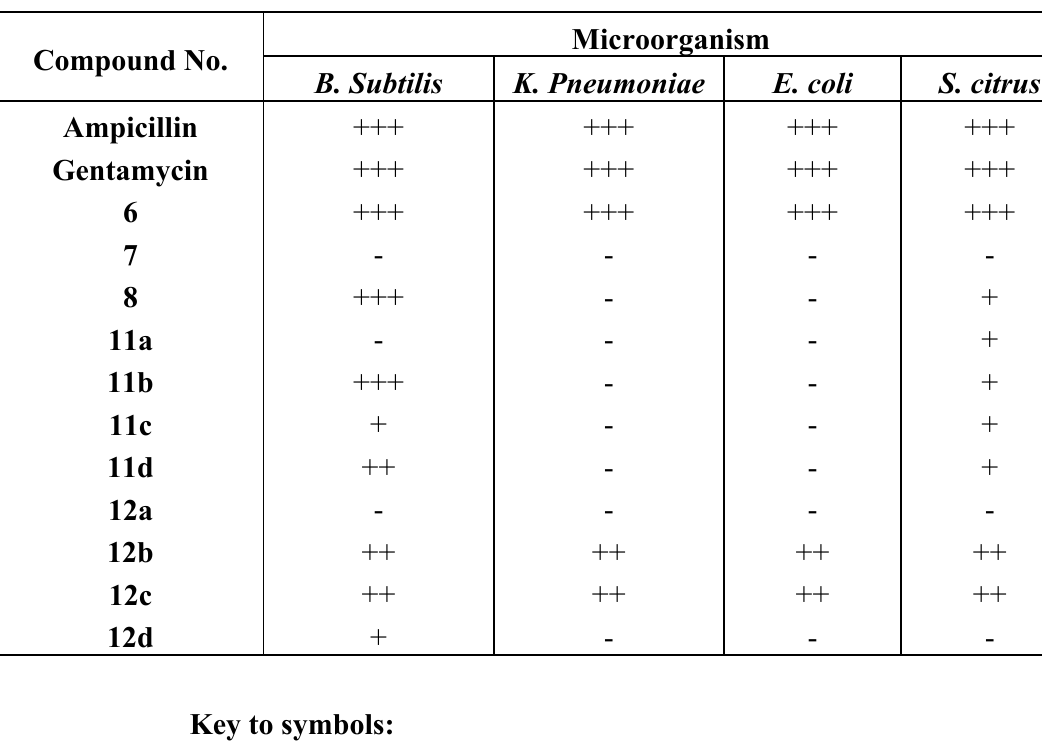
Table 1 . Results of antimicrobial activity tests of the synthetic monocyclic β -lactams. Compound